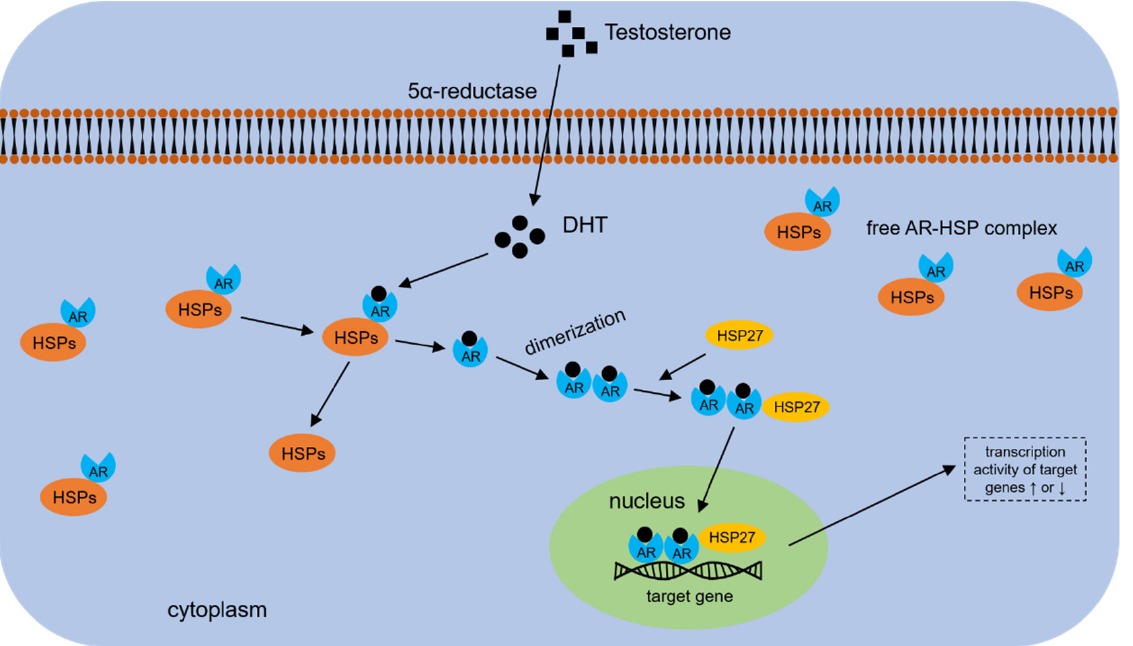
Figure 2. Schematic illustration of androgen-AR action in prostate cells. HSPs, including HSP70s and HSP90s, are in complexes with AR molecule in the cytoplasm. Testosterone is converted into DHT by 5 α -reductase; this action allows HSPs to disassociate from the AR-HSPs complex and facilitates AR dimerization. The AR dimer then translocates into the nucleus and binds to the promoter regions of target genes by recognizing androgen response elements (AREs), thereby performing its various